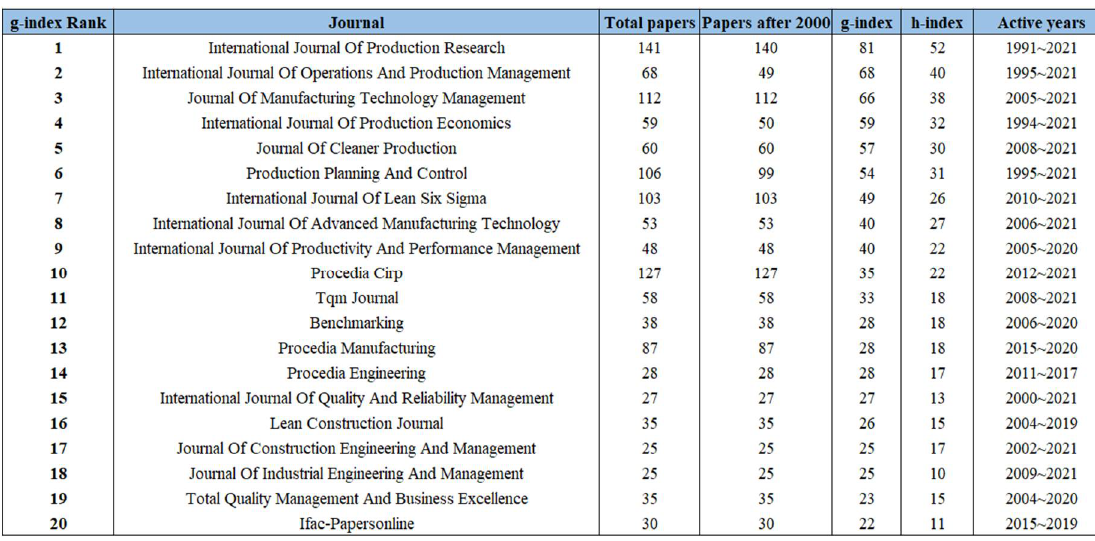
Figure 2. The top 20 journals.